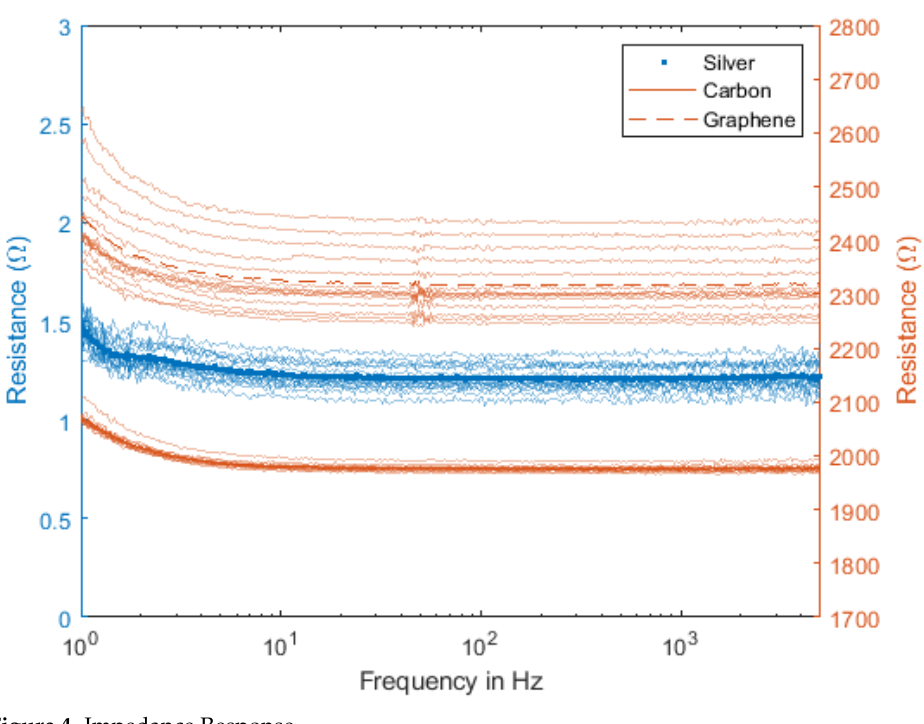
Figure 4. Impedance